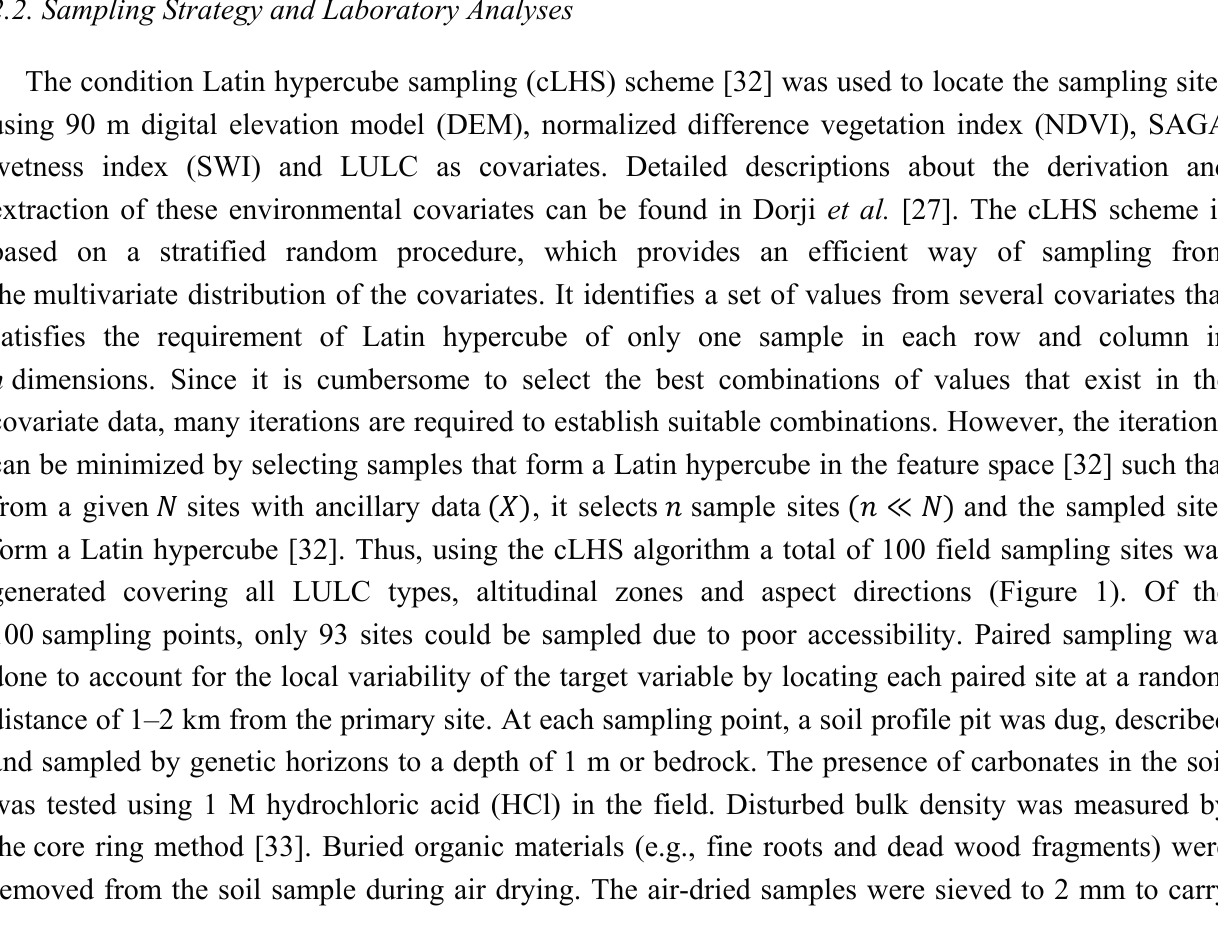
MAT = mean annual temperature, MAP = mean annual precipitation, Max = maximum, Min = minimum, LULC = land use/land cover, BPF = blue pine forest, BF = broadleaf forest, MCF = mixed conifer forest, FF = fir forest, SH = shrublands, GL = grasslands, HO = orchards, PL = paddy land, DL = dry land agriculture and ND = No